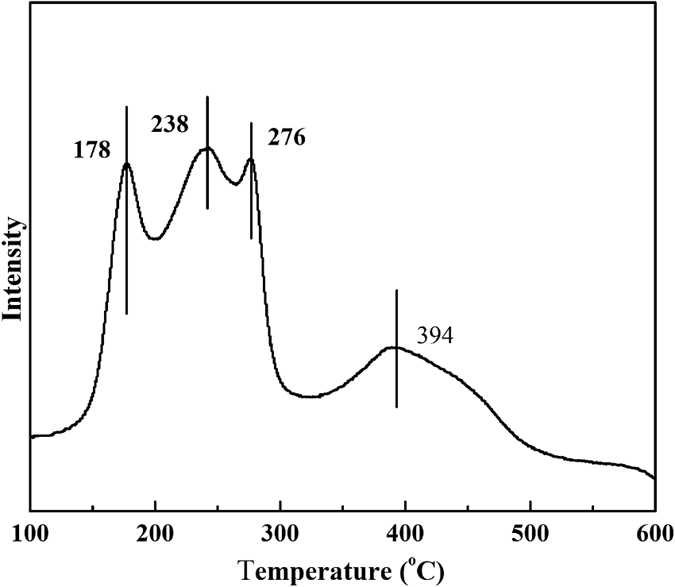
H2-TPR profile before reaction.